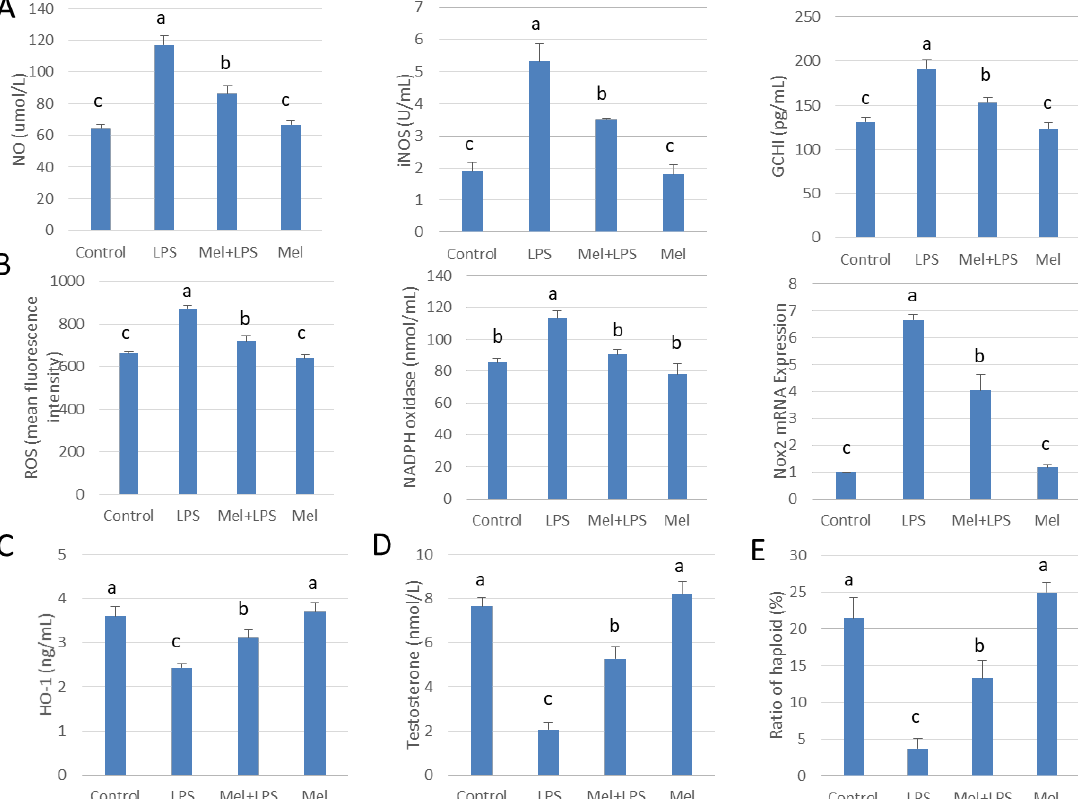
Figure 8. Melatonin administration increases haploid spermatogenic cell content in LPS-induced sheep orchitis. ( A ) NO content, iNOS viability and GCH1 protein expression. ( B ) ROS content, NADPH oxidase vitality and mRNA expression of Nox2. ELISA detected ( C ) HO-1 versus ( D ) testosterone content. ( E ) Percentage of haploid spermatogenic cells flow analysis. All the above experiments were divided into a control group (testicular local injection of saline), LPS injection group, LPS+Mel injection testis group and Mel injection testis group. Data are shown as mean ±SEM. Different superscript letters (a–c) in each column representative statistically significant differences ( p < 0.05).